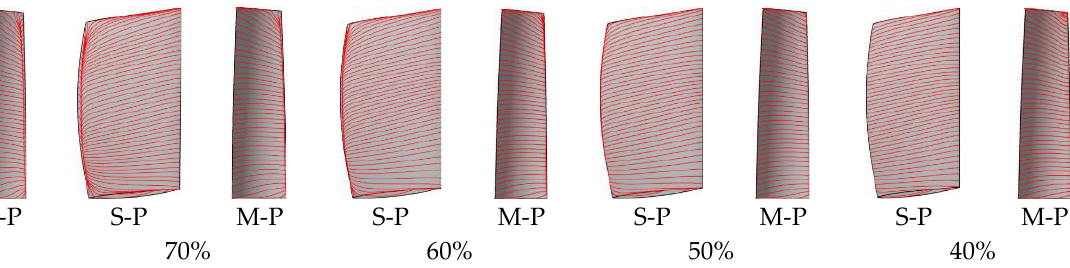
Figure 9. Limiting streamlines on S-P and M-P surfaces at different loads (1.9 MPa back pressure, last stage blade) .